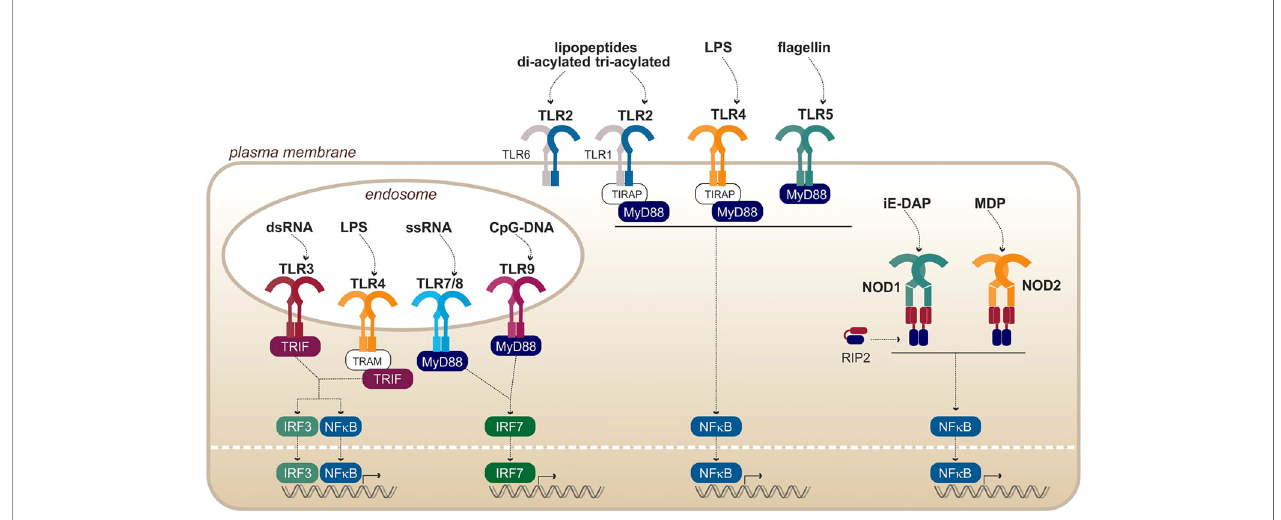
FIGURE 3 | Overview of PRRs from the TLRs and NODs families, with their respective ligands. Adapted from Kawai and Akira